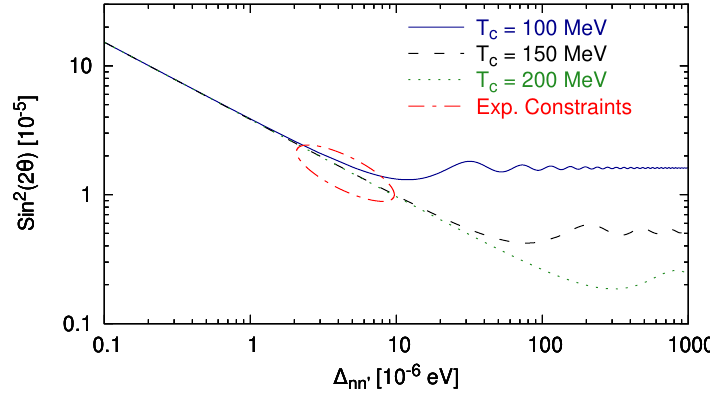
Figure 6. The mixing strength sin 2 ( 2 θ ) is shown as a function of the mass difference ∆ nn (cid:48) , assuming a mirror-to-ordinary baryon ratio of 5.4 in the universe. The QCD phase transition temperature is varied to be T c = 100,150,200 MeV, respectively. Adapted from Ref.